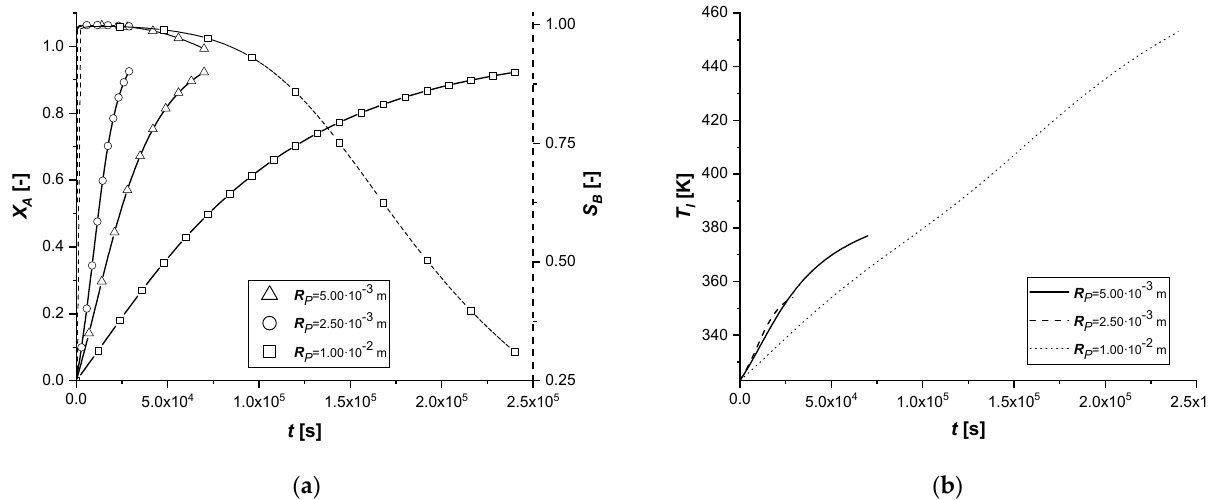
Figure 21. EW R P investigation. ( a ) Bulk profiles over time of X A and S B . ( b ) Bulk profile of T l over time.